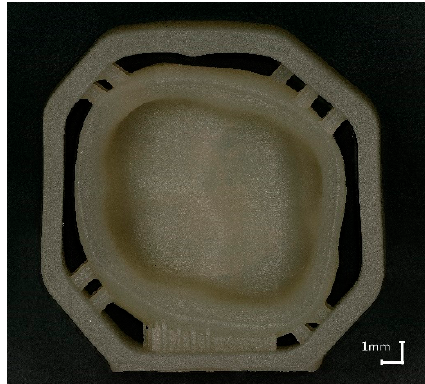
Figure 11. Molar crown with ‘milling’ support, additively manufactured, sintered.